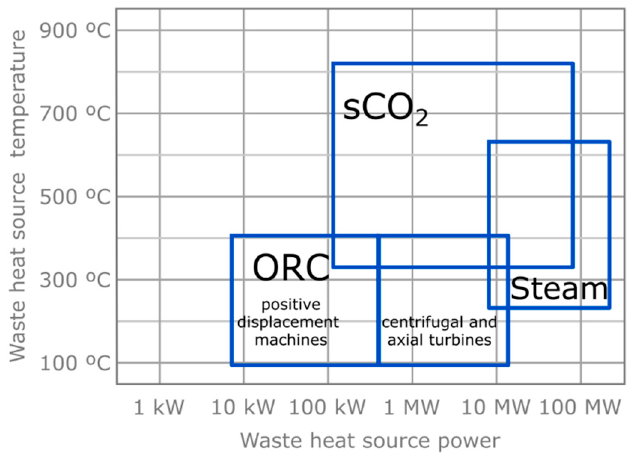
Figure 24. Technologies for waste heat recovery depending on source temperature and power (data source: [89]).